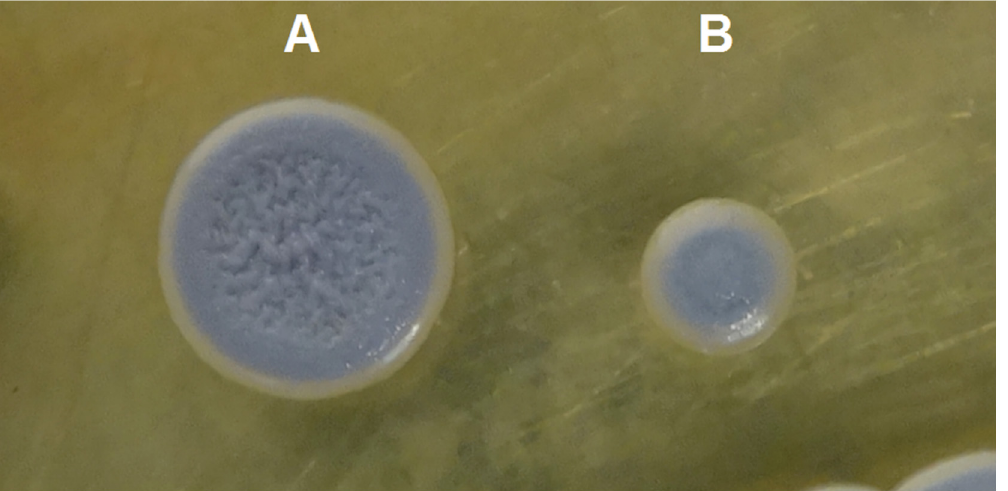
Fig 1. Burkholderia pseudomallei colony morphotypes. (A) Wild Type, WT and (B) small colony variant, SCV morphotypes grown for 4 days at 37°C on Ashdown agar.